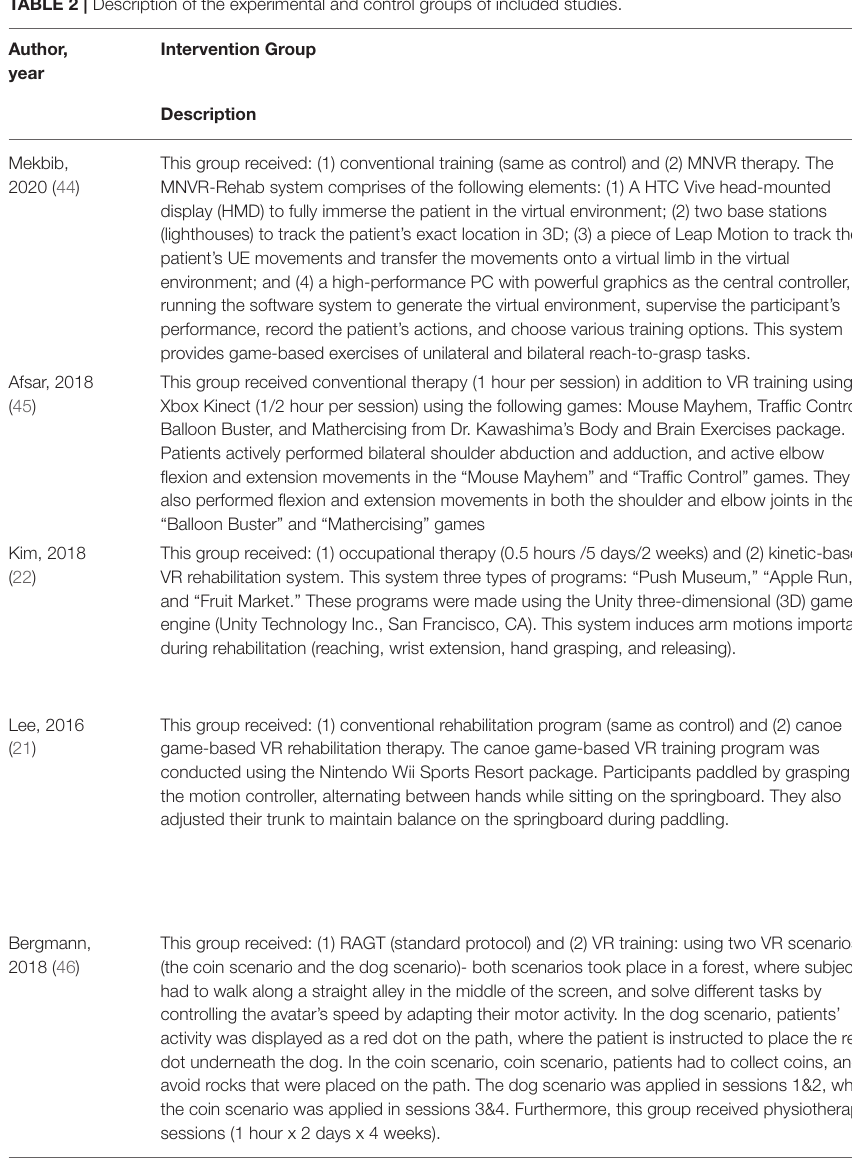
TABLE 2 | Description of the experimental and control groups of included